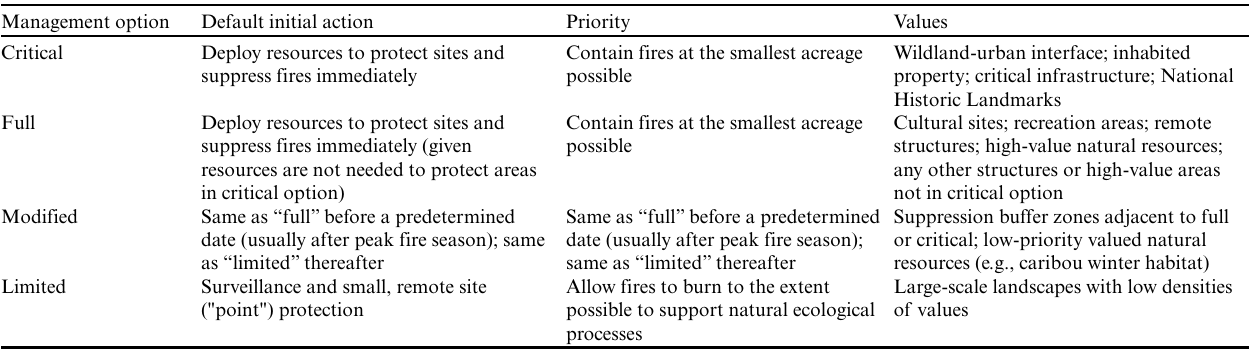
Table 1 . Fire management options (AWFCG